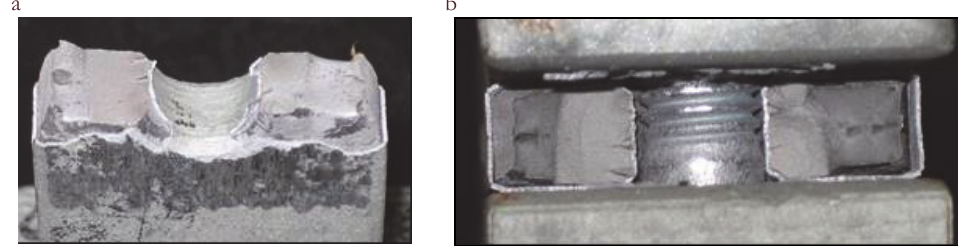
Figure 5: Typical fracture surface after cyclic loading. (a) Plate and (b) bolted part.